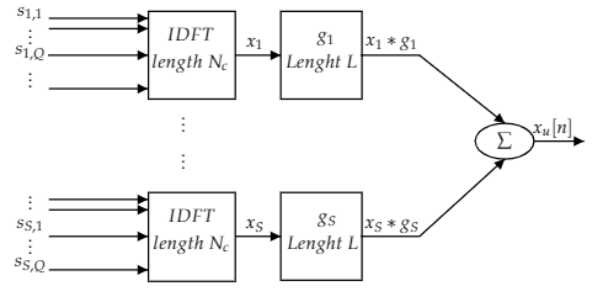
Figure 4. Universal filtered multicarrier (UFMC)